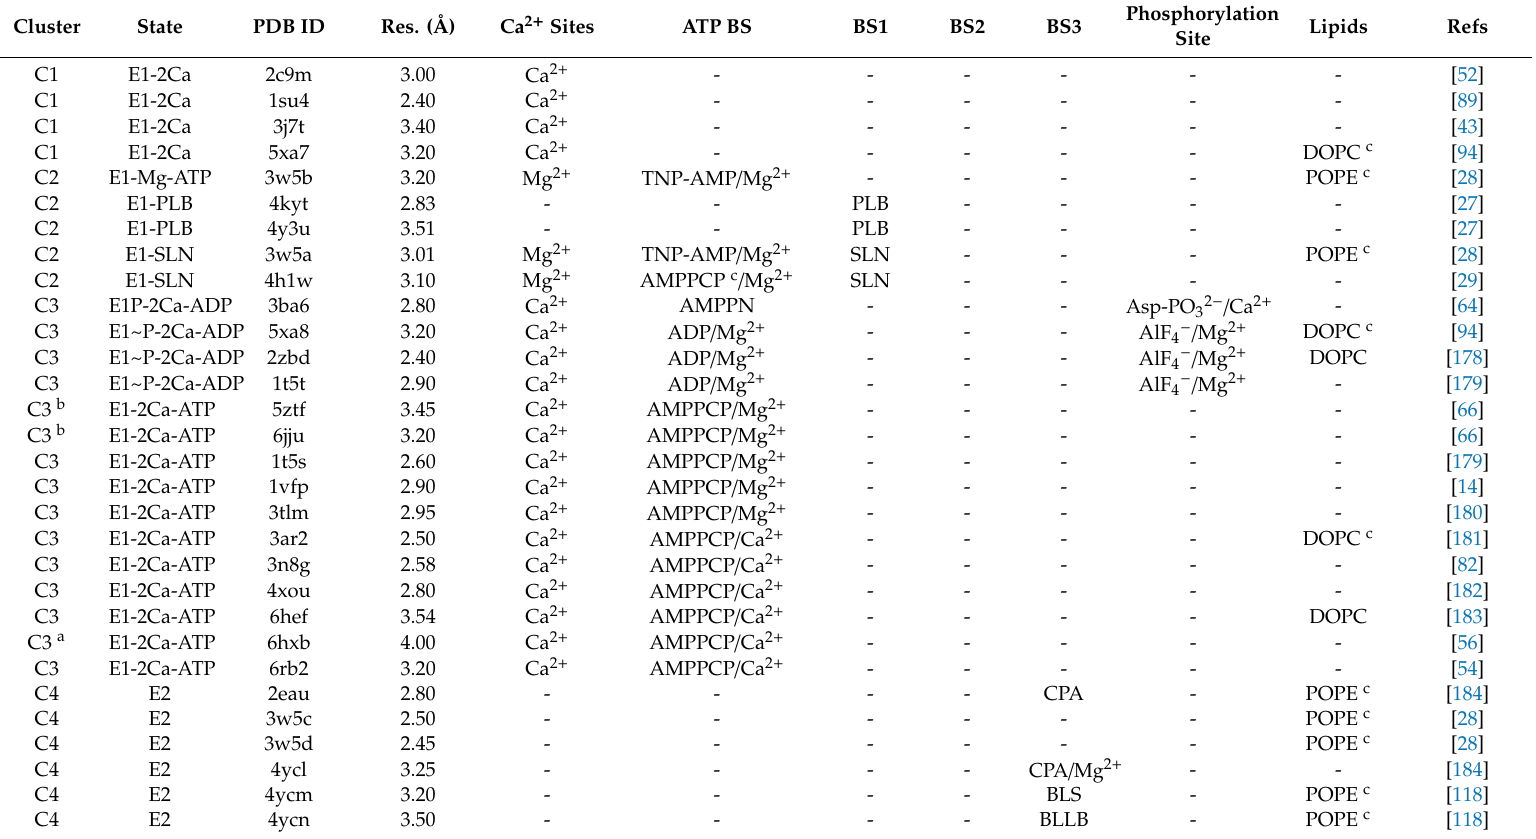
Table A1. Published SERCA structures classified using RMSD-based clustering